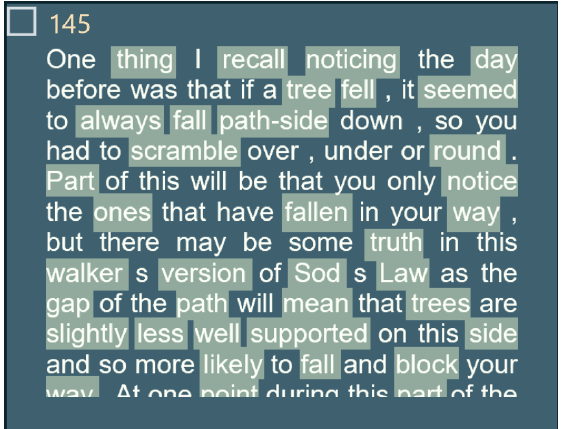
Figure 3. A paragraph card on tabletop interface. Words with background color are recognized keywords. This card illustrates an experience of mountain climbing (A1). Showing actual content allows re-visit experience details.